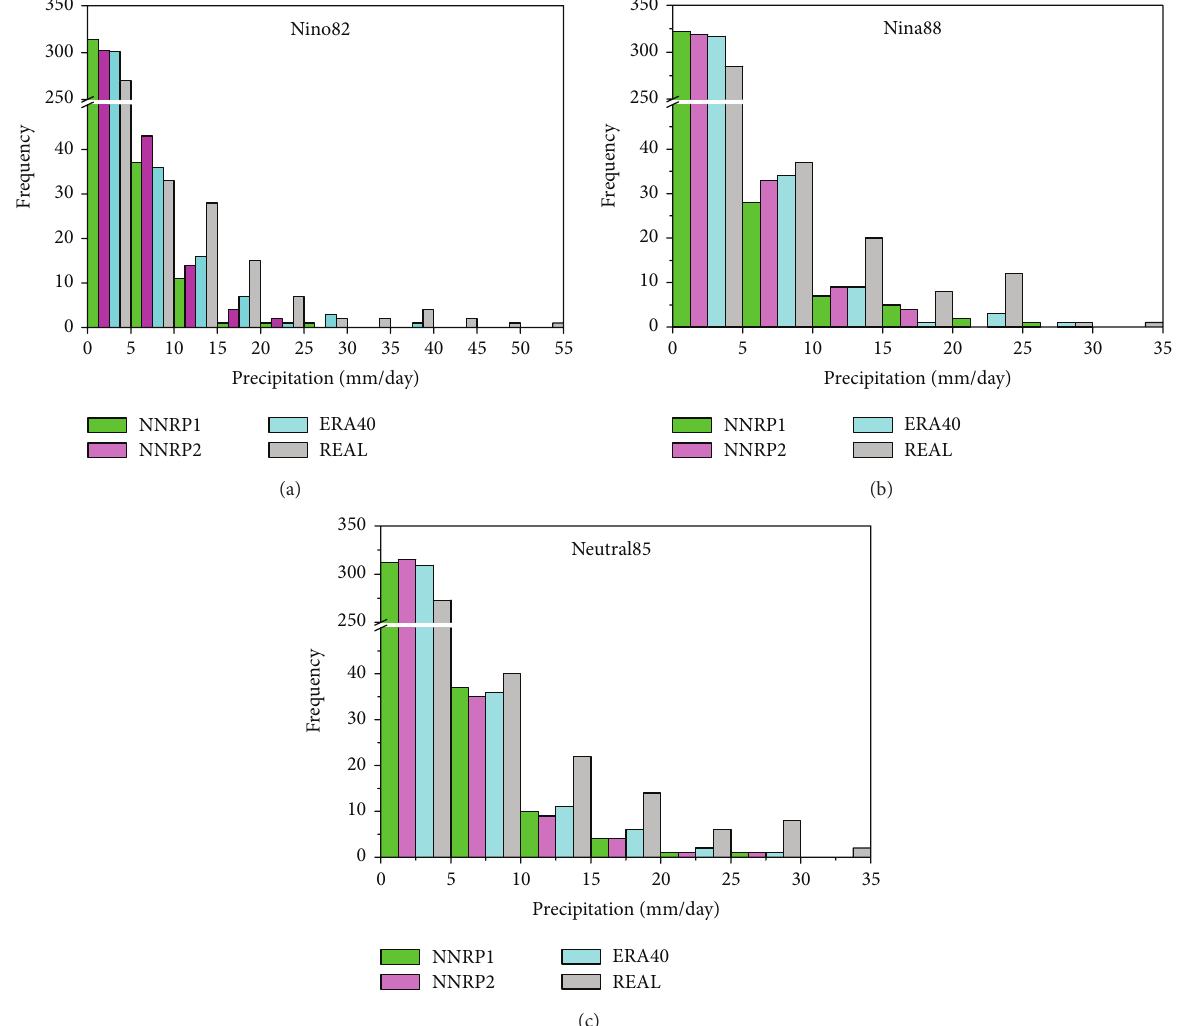
Figure 3: Frequency histogram to Nino82, Nina88, and